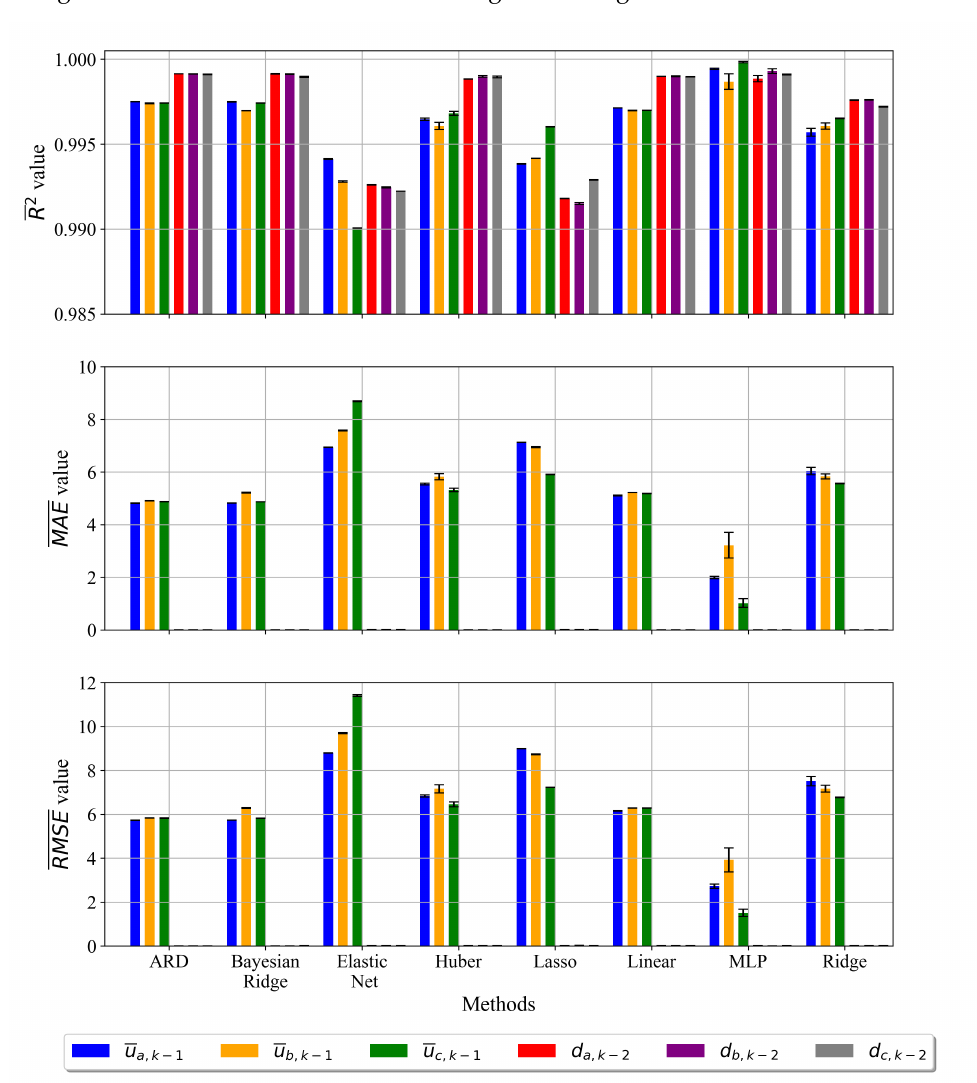
Figure 10. R 2 , MAE , and RMSE values with standard deviation achieved with each ML algorithm using randomized hyper-parameter search with